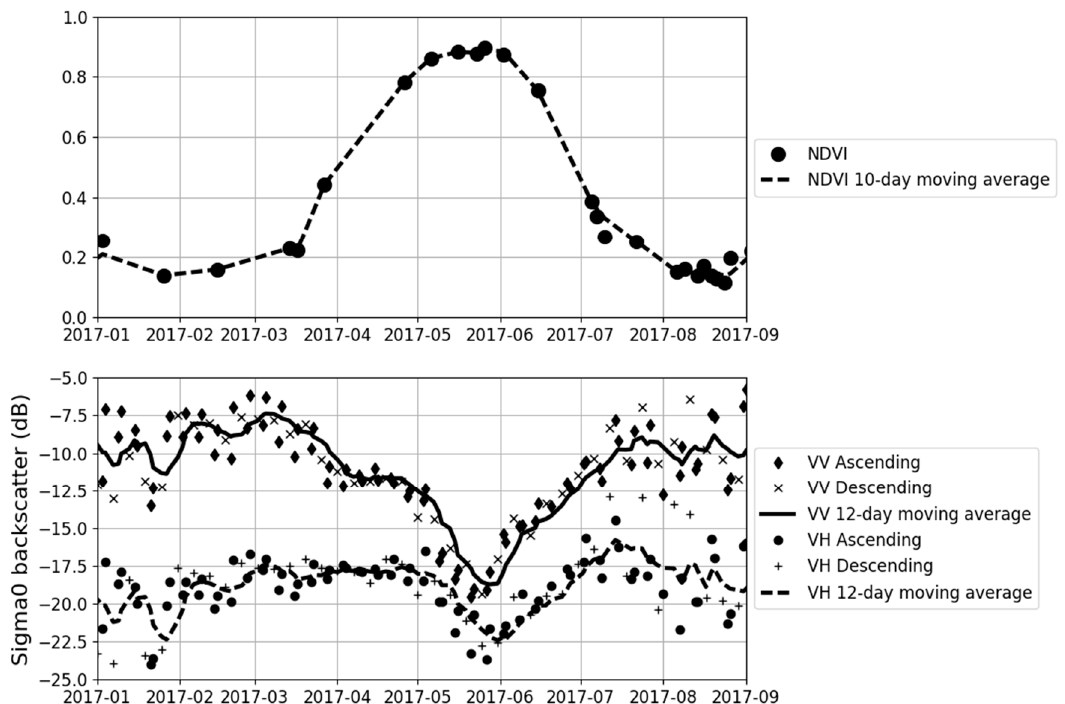
Figure 1. Example of profiles of ( upper panel ) Sentinel-2 normalized difference vegetation index (NDVI) and ( lower panel ) Sigma0 VV and VH backscatter intensities for a winter wheat field. The characteristic increase in NDVI during plant development, followed by a decrease during ripening and harvest, are well correlated with the decrease in mostly VV backscatter during the growth phase of the plant. During senescence and harvest, backscatter intensities start increasing again.